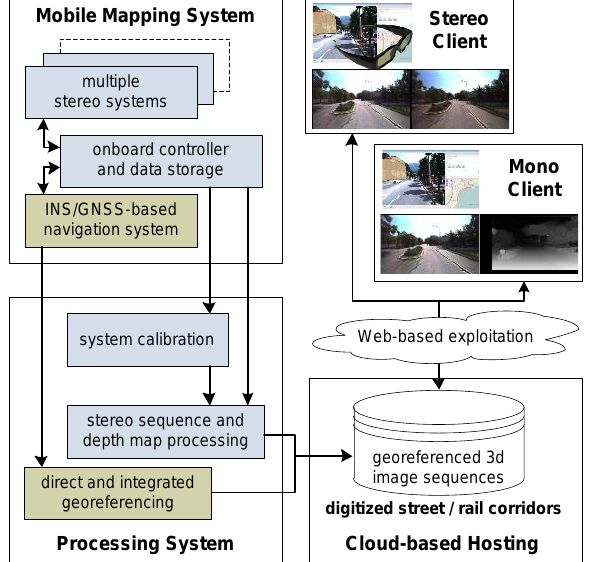
Figure 2: Stereo vision data pipeline and distributed use